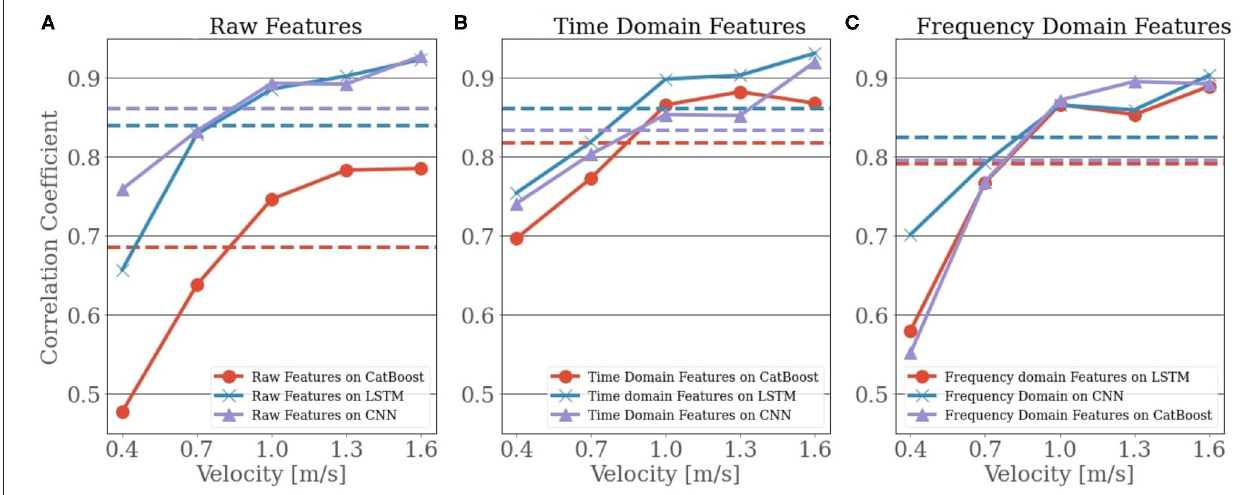
FIGURE 4 | The plot shows the speed-wise correlation coefficient for the three models, Cat Boost Regressor (CBR), Long-Short Term Memory (LSTM), and Convolutional Neural Network (CNN), with each being separated into the three feature sets. The dashed lines represent the average over the velocities. In (A) the raw signal was used as predictors, where in (B) used the extracted time-domain features and in (C) the extracted features in frequency domain were used. TABLE 2 | The averaged metric values over the 9 participants for the Long-Short Term Memory (LSTM) and Convolutional Neural Network (CNN) on the three feature sets. Correlation coefficient 0.4 m / s CNN on raw